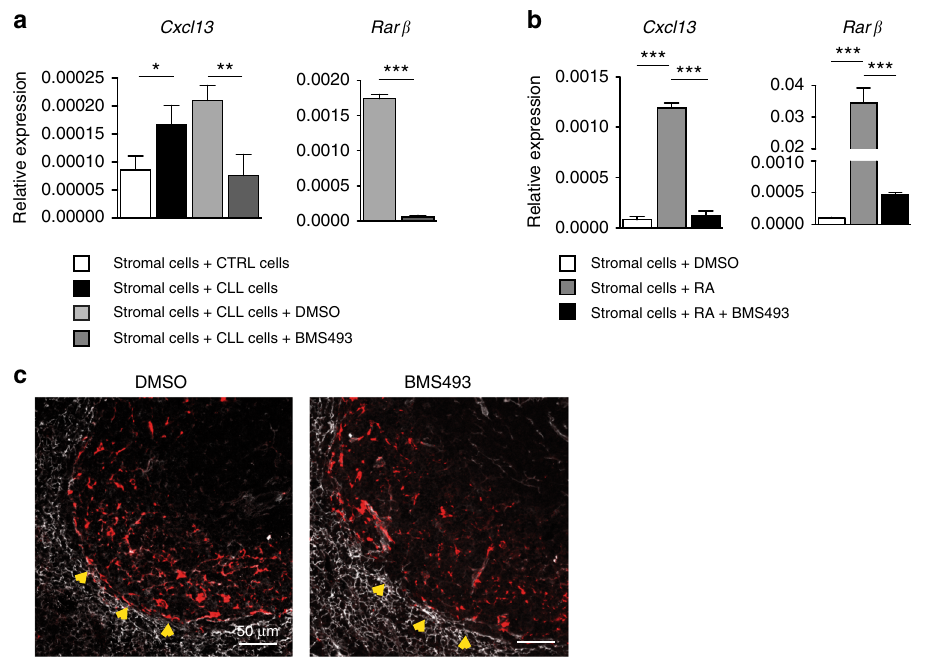
Fig. 3 Leukemic cells induce Cxcl13 expression in stromal cells through retinoid-signaling. a qPCR analysis of Cxcl13 expression from a murine stromal cell line (mSSC) cultured with murine E μ -TCL1 CLL cells or control splenic B cells, and after treatment with DMSO or BMS493. Expression of Rar β after BMS493 treatment was used as control. The mean of triplicates and ±SD are shown, * p < 0.05, ** p < 0.01, *** p < 0.001. b Representative qPCR analysis of Cxcl13 expression from a murine stromal cell line (mSSC) cultured in vitamin A de fi cient media and treated with vehicle (DMSO), retinoic acid (RA), or BMS493. Expression of Rar β after BMS493 treatment was used as control. qPCR data are representative of one out of three independent experiments. The mean of triplicates and ±SD are shown, *** p < 0.001. c Representative confocal images of the spleen from wild type mice treated with either DMSO (left) or BMS493 (right). Tissue sections were stained for laminin (ECM) (gray) and CXCL13 (red). Yellow arrowheads indicate the outer follicular region. Images are representative of one out of three mice analyzed. Scale bars = 50 μ